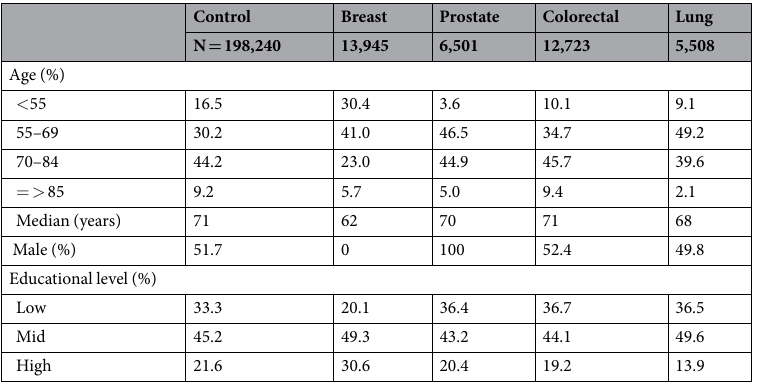
Table 1. Characteristics of the study population.